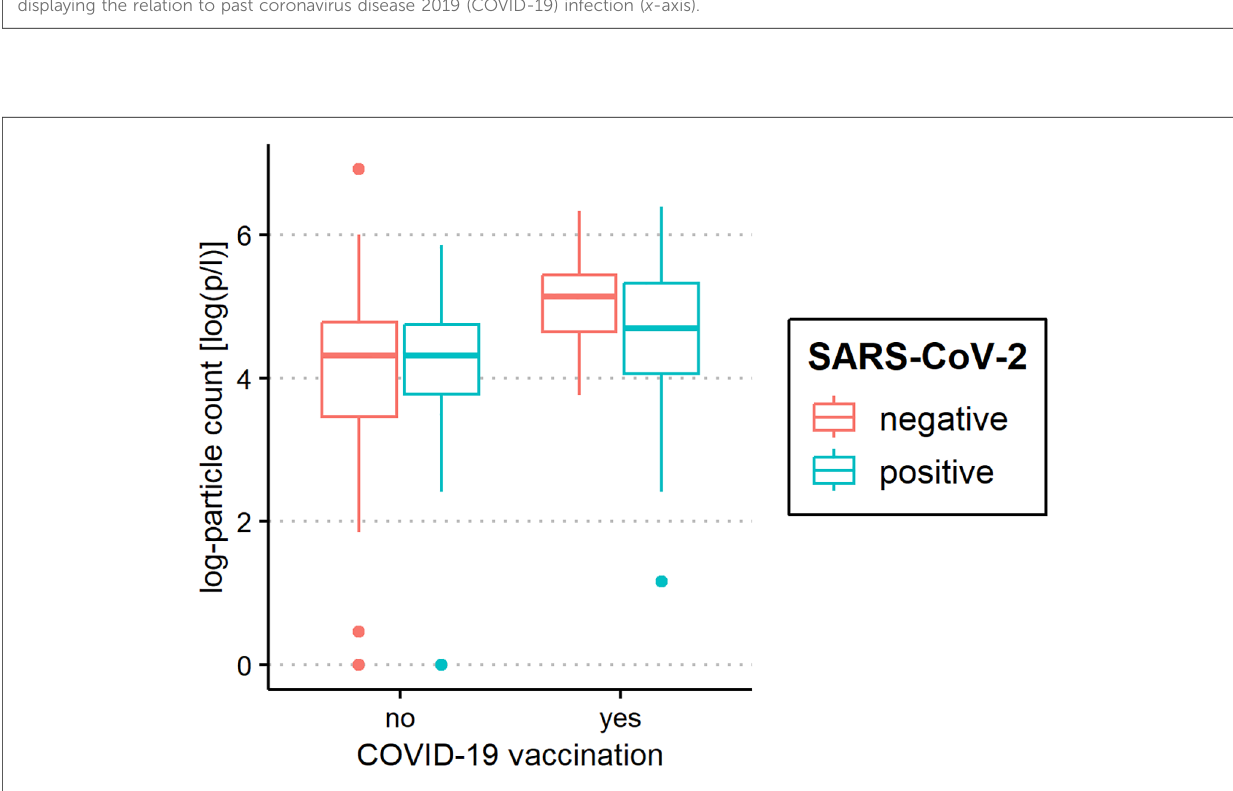
FIGURE 6 Aerosol measurement in relation to coronavirus disease 2019 (COVID-19) vaccination status. Exhaled particle counts (in particles/liter, displayed on a logarithmic scale, y -axis) in severe acute respiratory syndrome coronavirus 2 (SARS-CoV-2) polymerase chain reaction (PCR) -positive and PCR- negative children and adolescents displaying the relation to COVID-19 vaccination status ( x